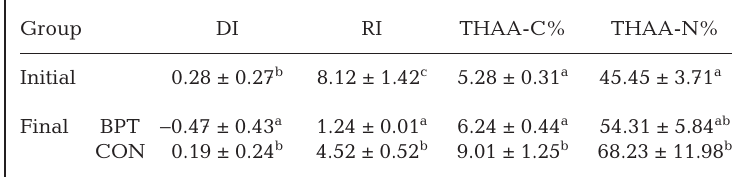
Table 3. Indicators of the degradation state of organic matter in sediments. Data are presented as mean ± SD (n = 3). Different letters within the same column in- dicate significant differences between the final Bellamya purificata treatment (BPT), the final control (CON), and the corresponding initial values (p < 0.05).